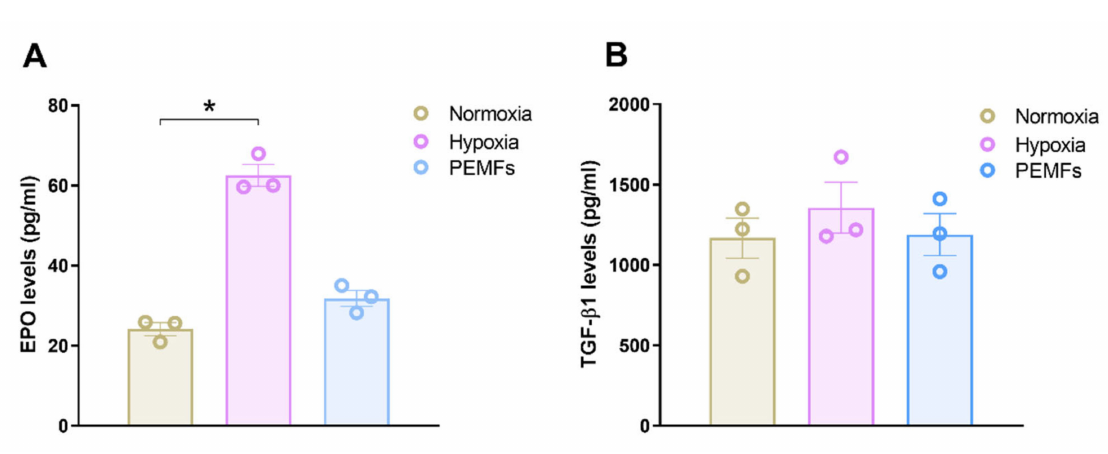
Figure 3. EPO and TGF- β 1 production by 1321N1 following normoxia, hypoxia or PEMF treatment in normoxia. ( A ) EPO levels measured in 1321N1 medium after 24 h of incubation in normoxia, hypoxia or PEMF exposure during normoxia. ( B ) Histograms depicting TGF- β 1 concentration in 1321N1 medium after 24 h of incubation in normoxia, hypoxia or PEMF exposure during normoxia. Data are expressed as mean ± SEM of three independent experiments. *, p < 0.01 vs.